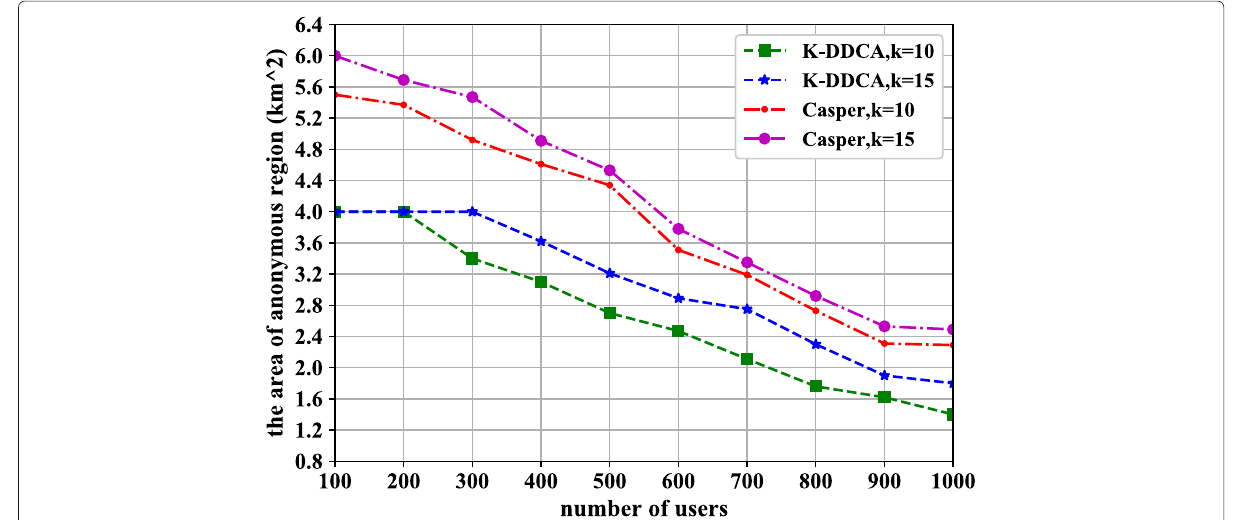
Fig. 8 Relationship between the number of users and the area of the anonymous region. It shows the relationship between the area of the anonymous region and the number of users under the condition of k = 10, k = 15 from the Casper algorithm and K-DDCA